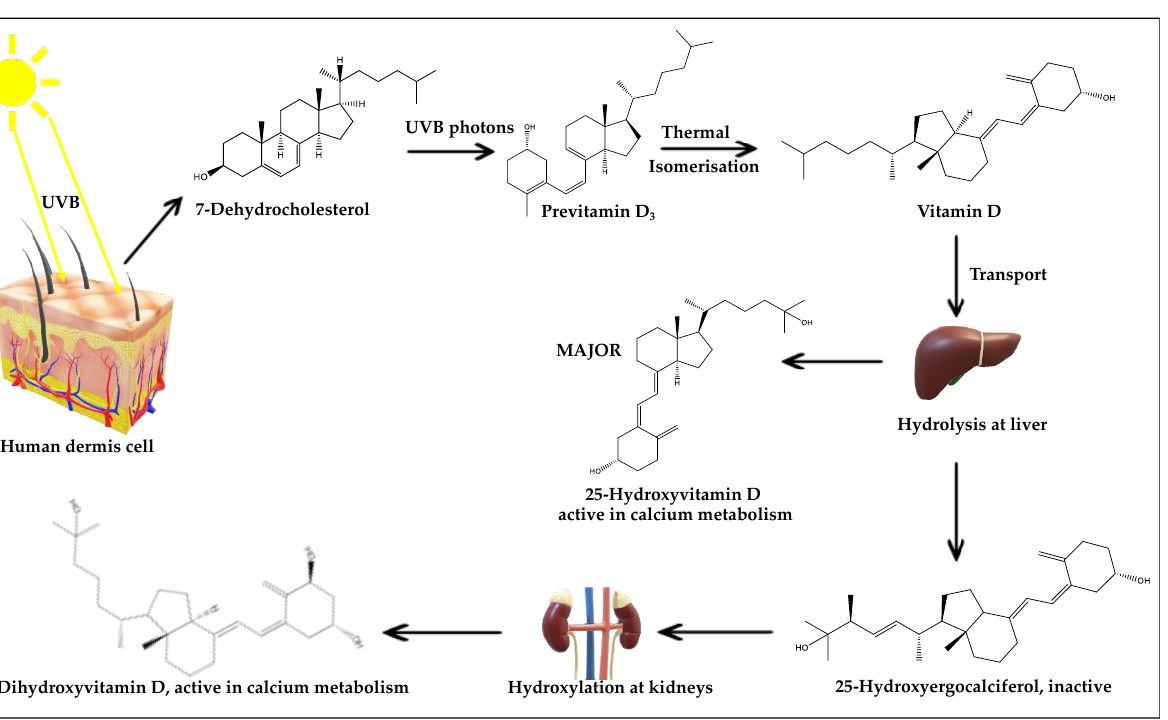
Figure 5. Vitamin D synthesis. Adapted from reference [48].